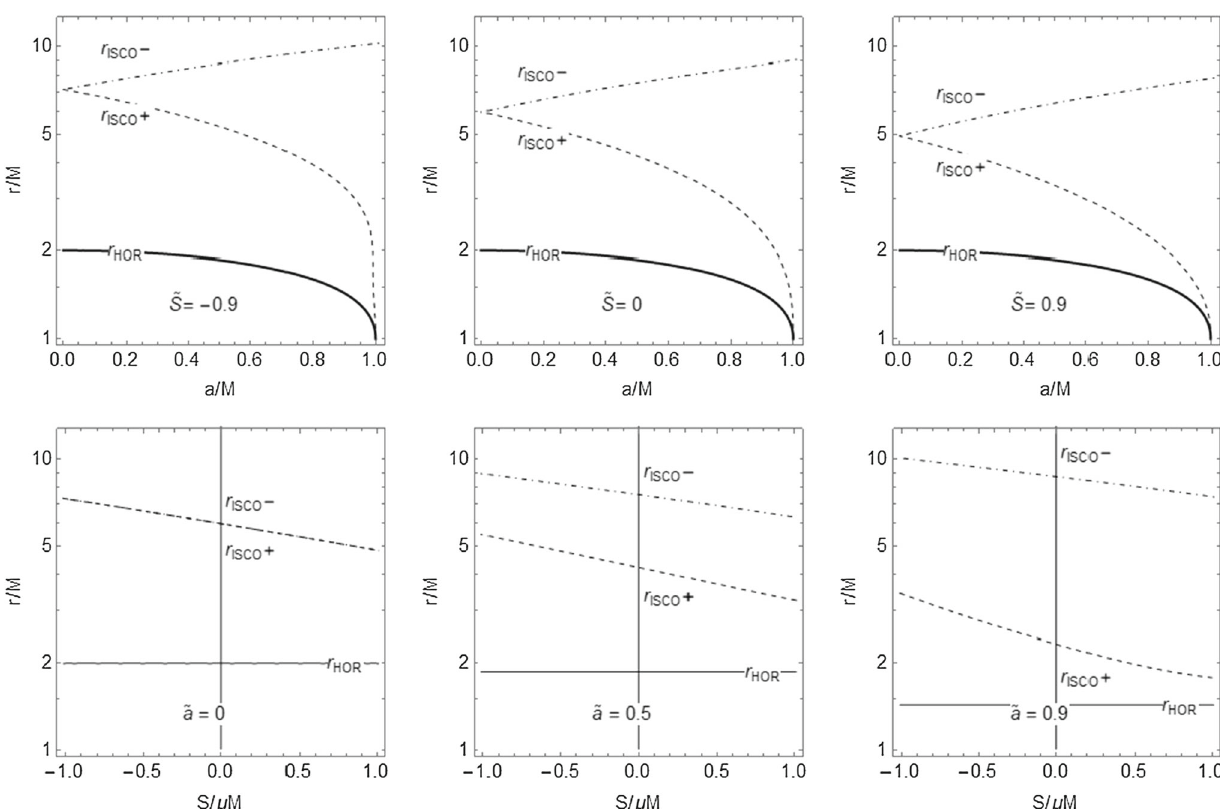
Fig. 1 The position of horizon and ISCO of a spinning neutral test particle orbiting Kerr BH. The first row is plotted for different values of spin parameter ˜ S while second row is plotted for different values of rotation parameter ˜ a the rotation of BH (co-rotation with BH), while spin is antiparallel to